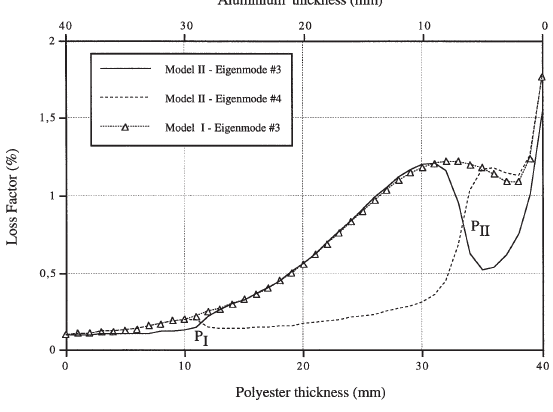
Fig. 2. The effect of thickness distribution on damping loss factor.